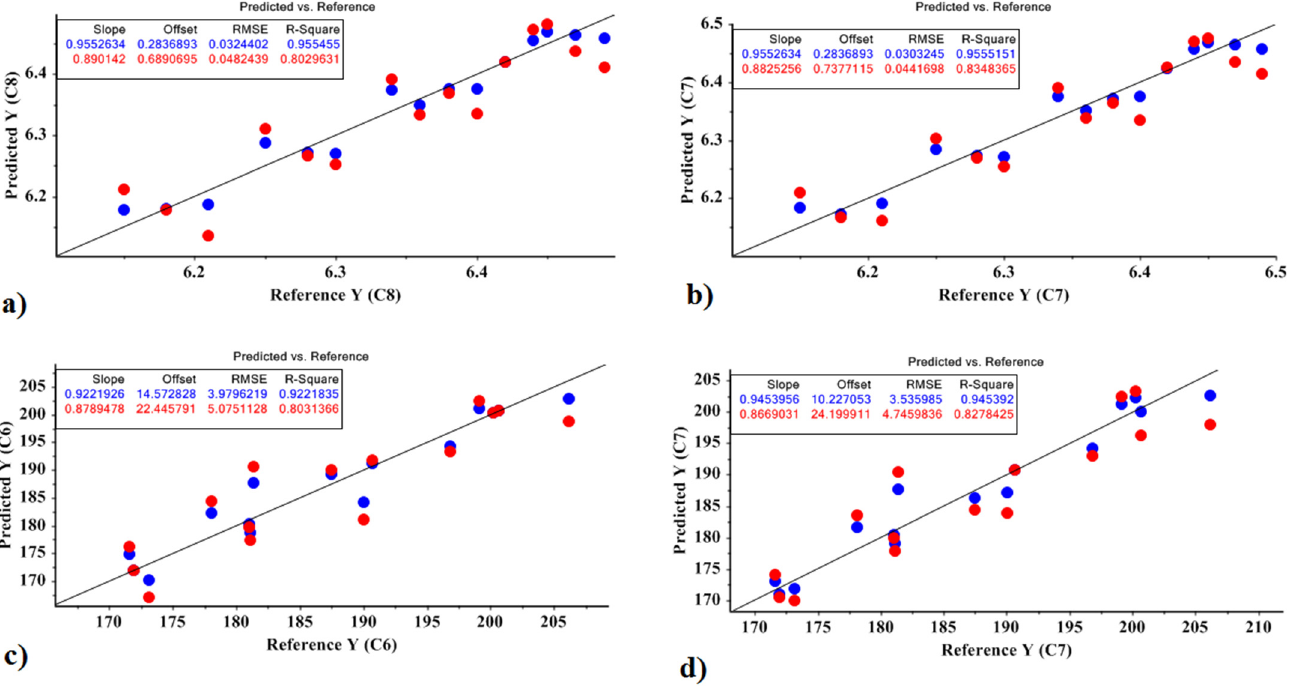
Figure 4. MLR prediction models for predicting the amount of carbohydrate and sugar in the Agria cultivar: ( a ) the amount of sugar based on the PCR method; ( b ) the amount of sugar based on the PLSR method; ( c ) the amount of carbohydrate based on the PCR method; ( d ) the amount of carbohydrate based on the PLSR method.